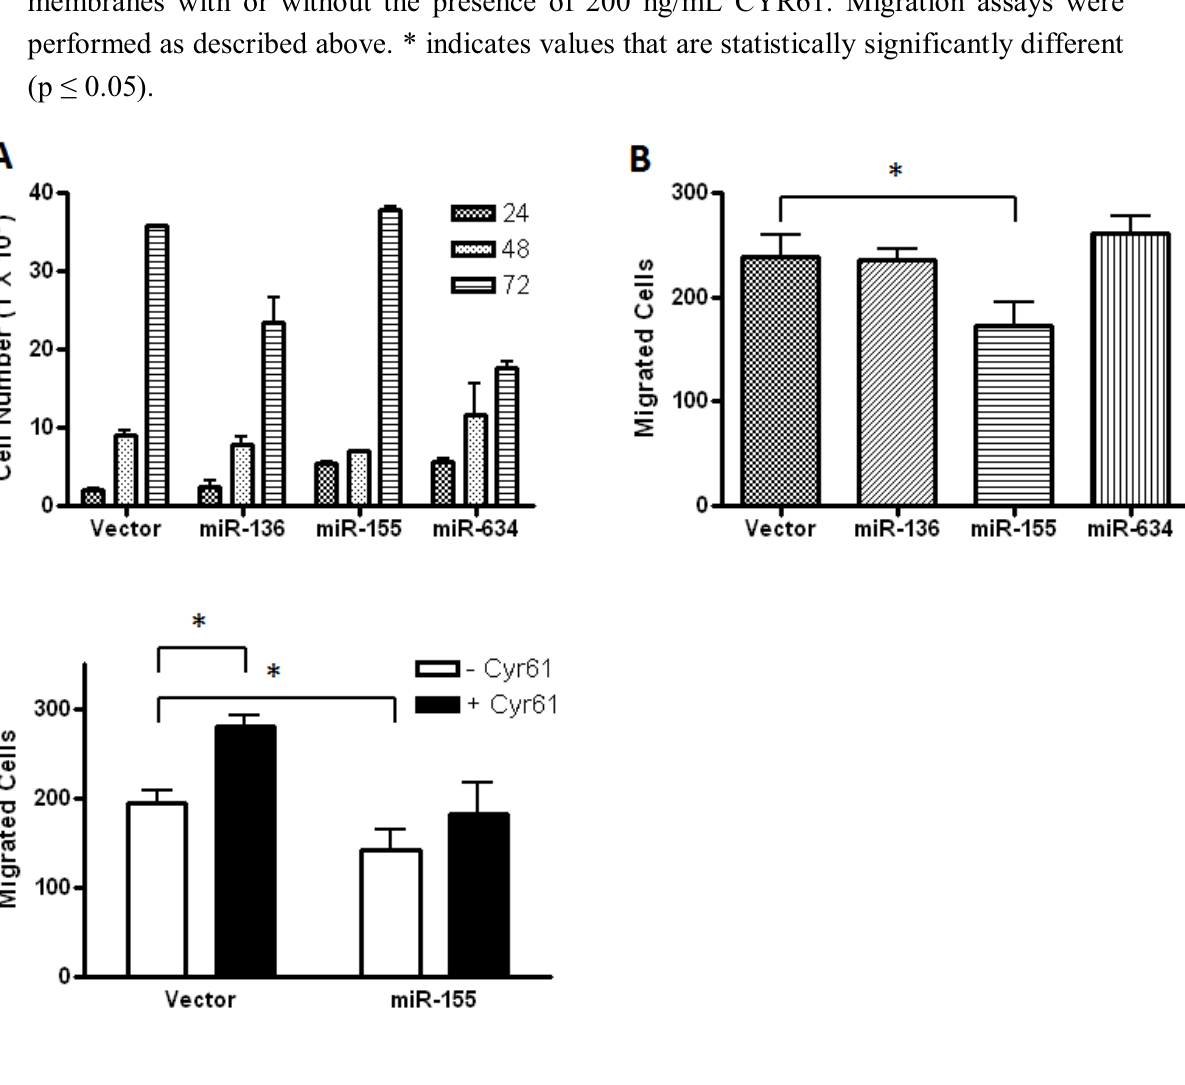
Figure 2. Differential effects of miR-136, miR-155, and miR-634 on cell growth and migration of LN229 cells. (A) Plot showing the growth of miRNA-expressing LN229 cells at 24 h, 48 h, and 72 h after plating. Experiment was repeated twice, each in duplicate. (B) Migration assay of miRNA-expressing LN229 cells. At 48 h post-transfection, GFP + cells were sorted onto 8 µm filter membranes and allowed to migrate for